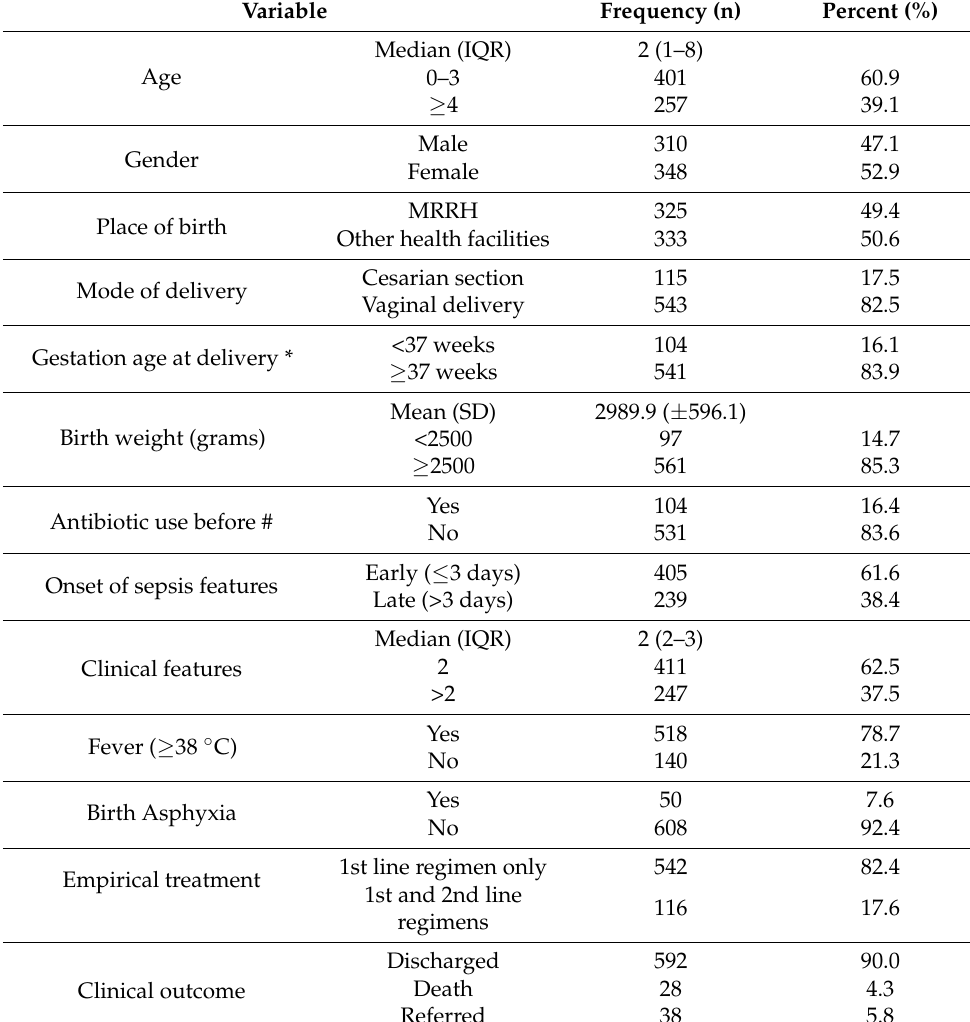
Table 1. Participants’ demographic and clinical characteristics (N =